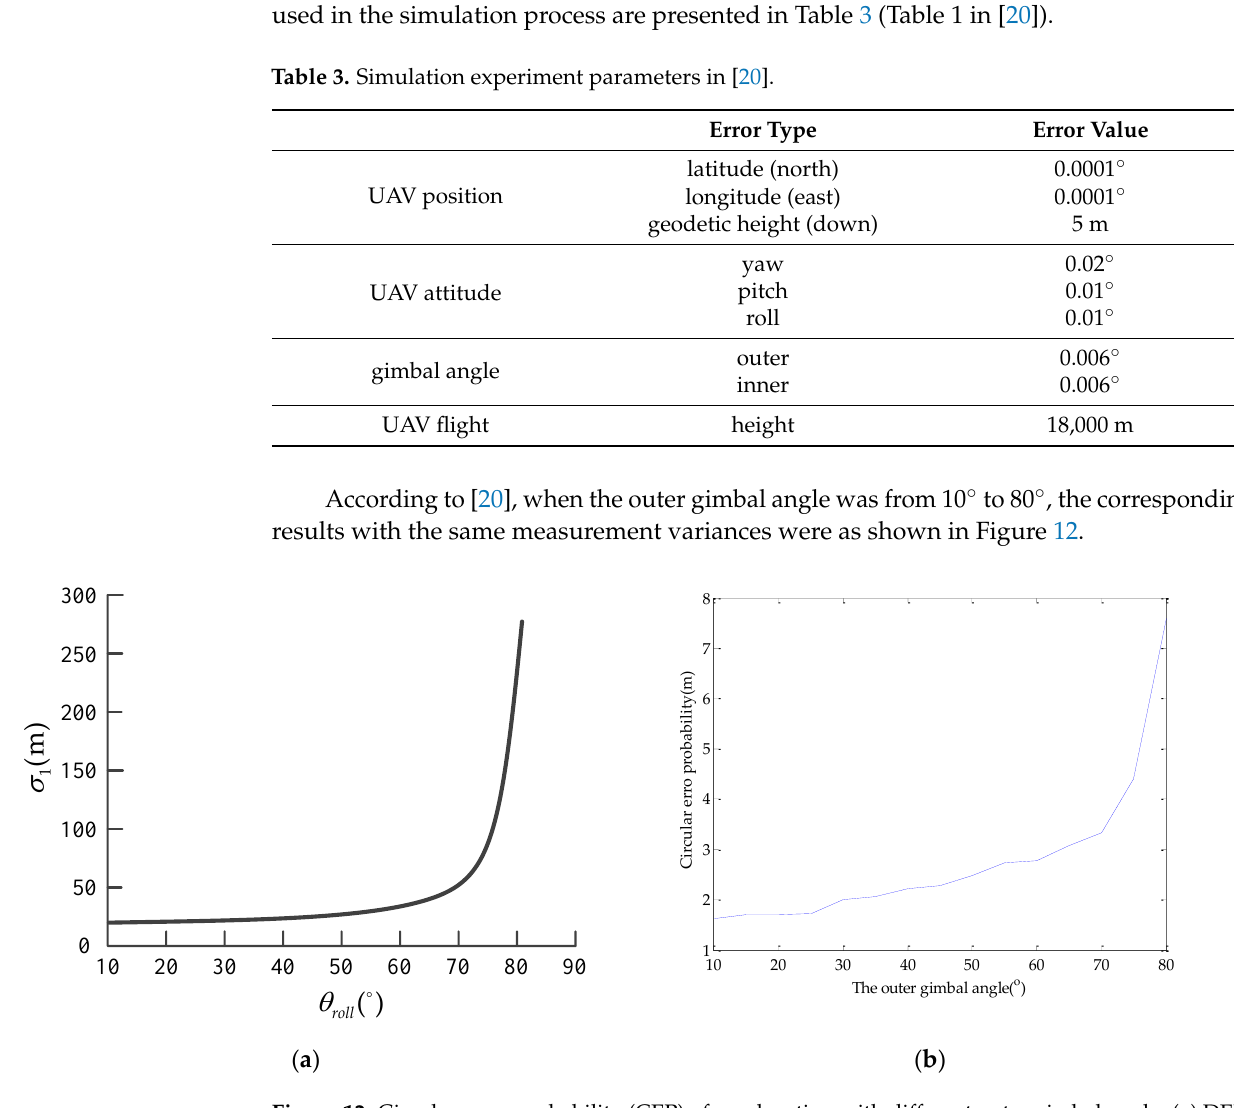
Figure 12. Circular error probability (CEP) of geo-location with different outer gimbal angle: ( a ) DEM method in [20], θ roll is the outer gimbal angles and σ 1 is circular error probability; ( b ) the proposed method.